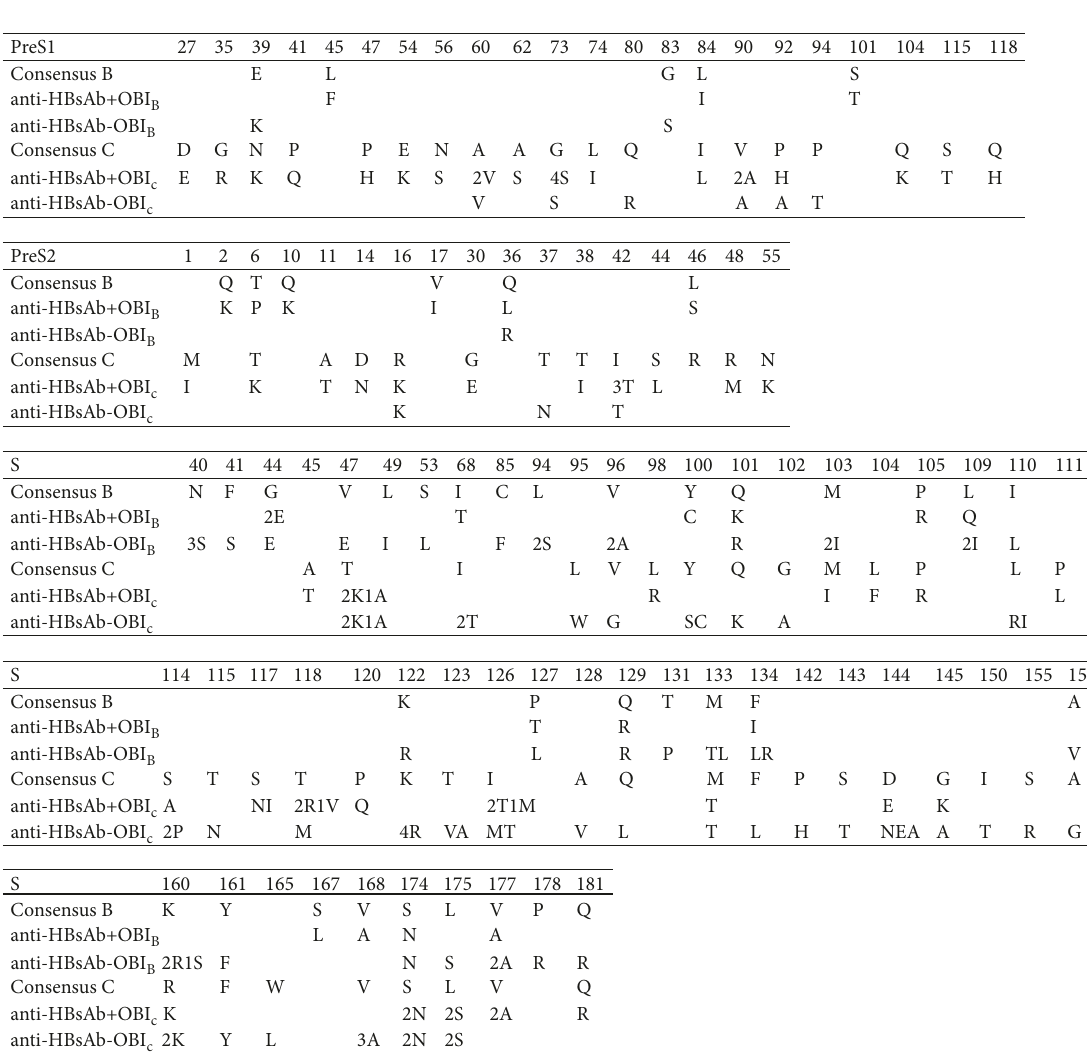
Figure 2: The alignment of amino acid substitutions in the pre-S/S region of anti-HBs (+) and anti-HBs ( prefix indicated the number of substitutions at each site in OBI sequences. OBI, occult hepatitis B virus infection; anti-HBs, hepatitis B surface